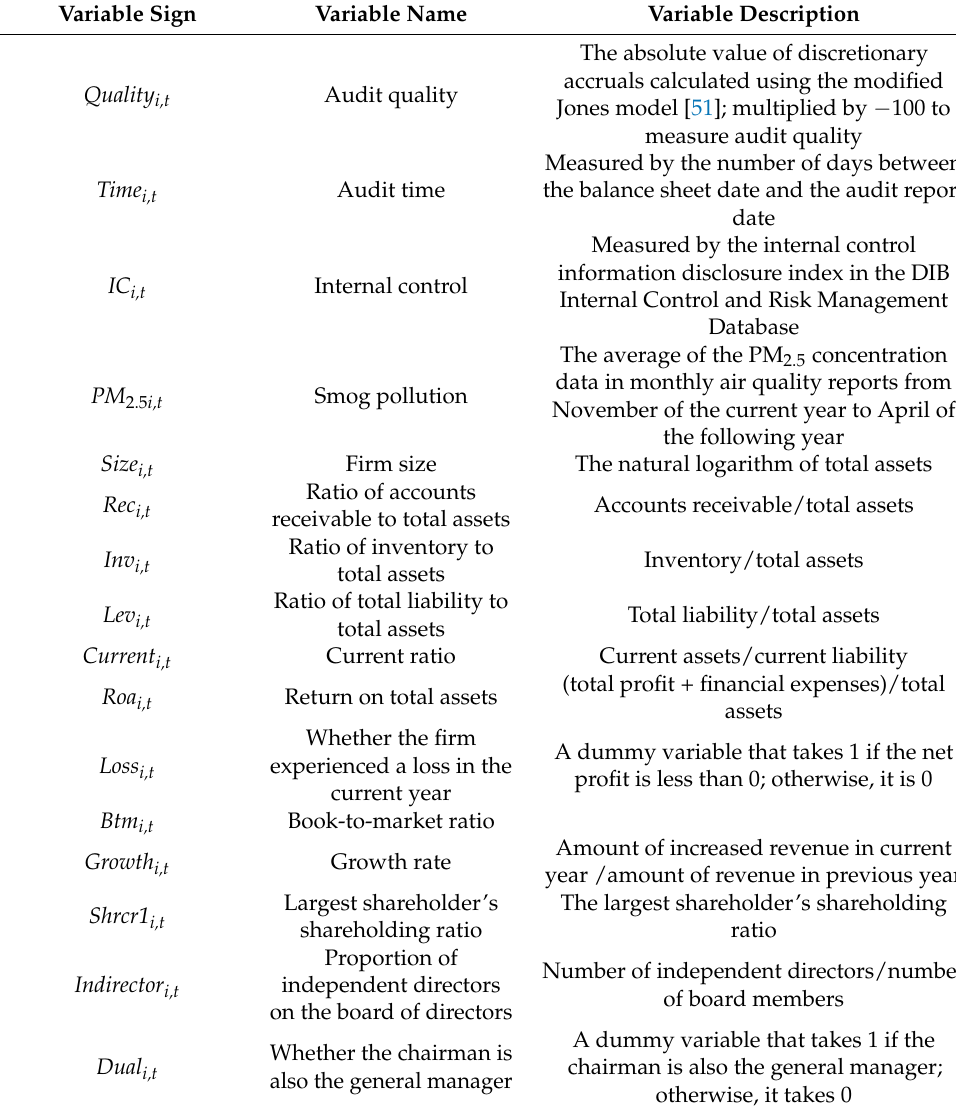
Table 1. Variable